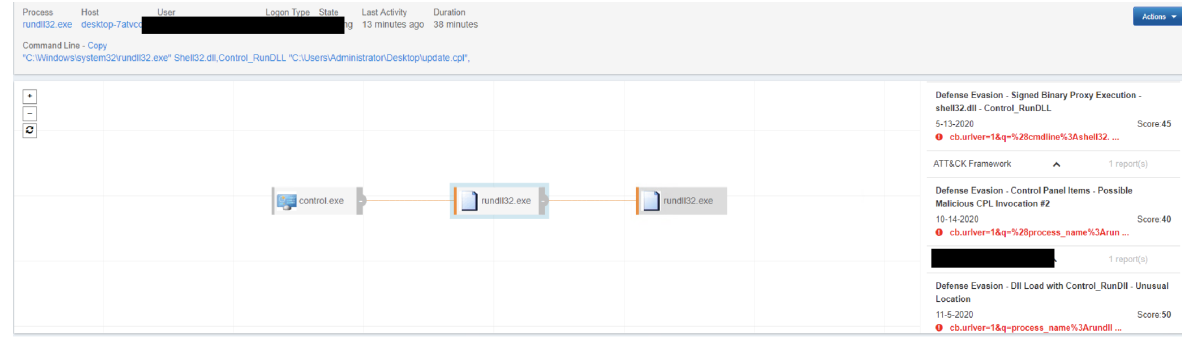
Figure 5. CPL’s IOCs produced by Carbon Black.